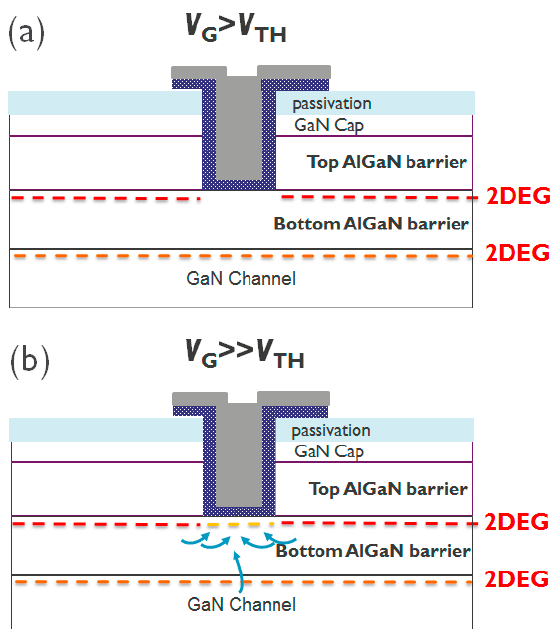
Figure 6. The schematic of proposed double channel model ( a ) when V G > V TH and ( b ) V G >>> V TH .